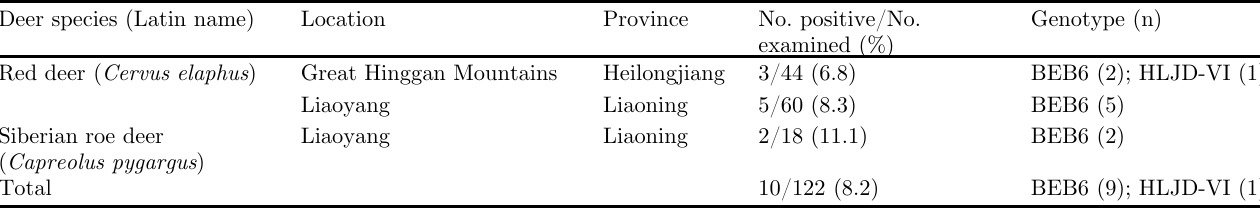
Table 1. Prevalence and genotypes of Enterocytozoonbieneusi in red deer and roe deer. Deer species (Latin name) Location